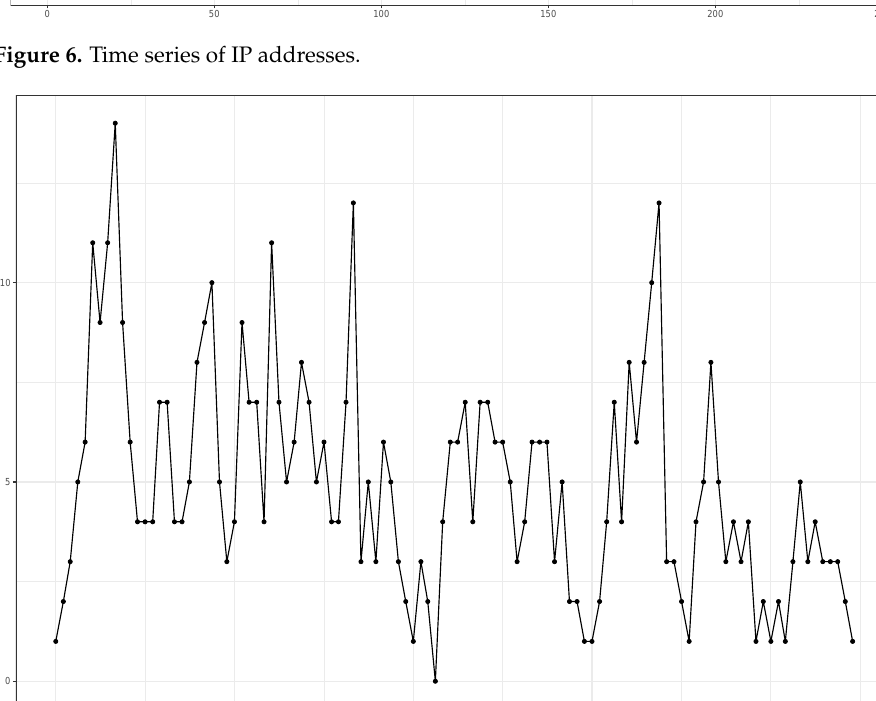
Figure 7. Montly time series of major strikes in U.S. between 1994 and